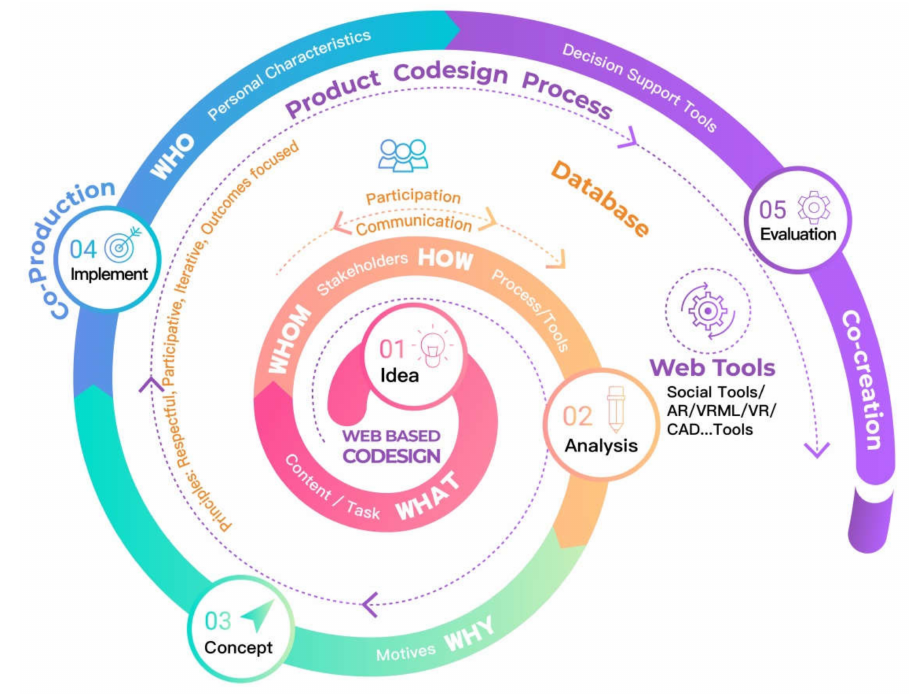
Figure 1. The framework of web-based